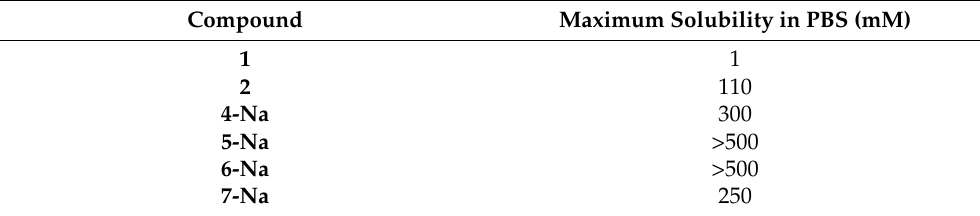
Table 1. The maximum solubility values in PBS of IRIs 1 & 2 and sodium phosphonate compounds ( 4–7 ).